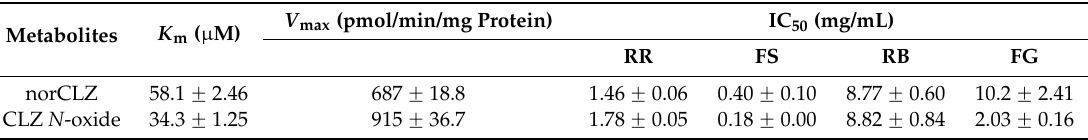
Table 2. Potency of inhibitory effects of Radix Rehmanniae (RR), Fructus Schisandrae (FS), Radix Bupleuri (RB) and Fructus Gardeniae (FG) on CLZ metabolism in human liver microsomes a .